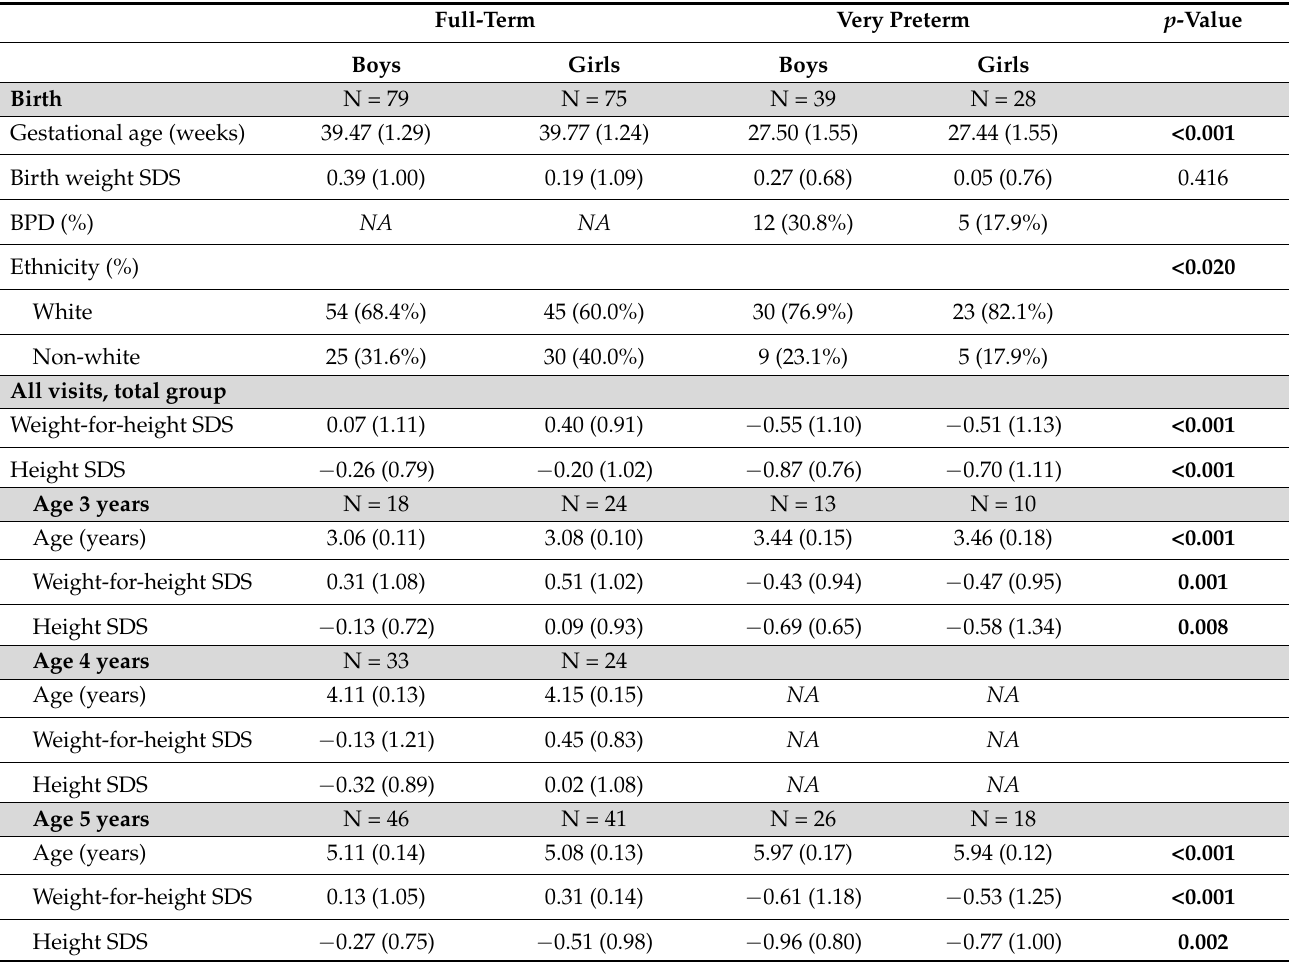
Table 1. Clinical